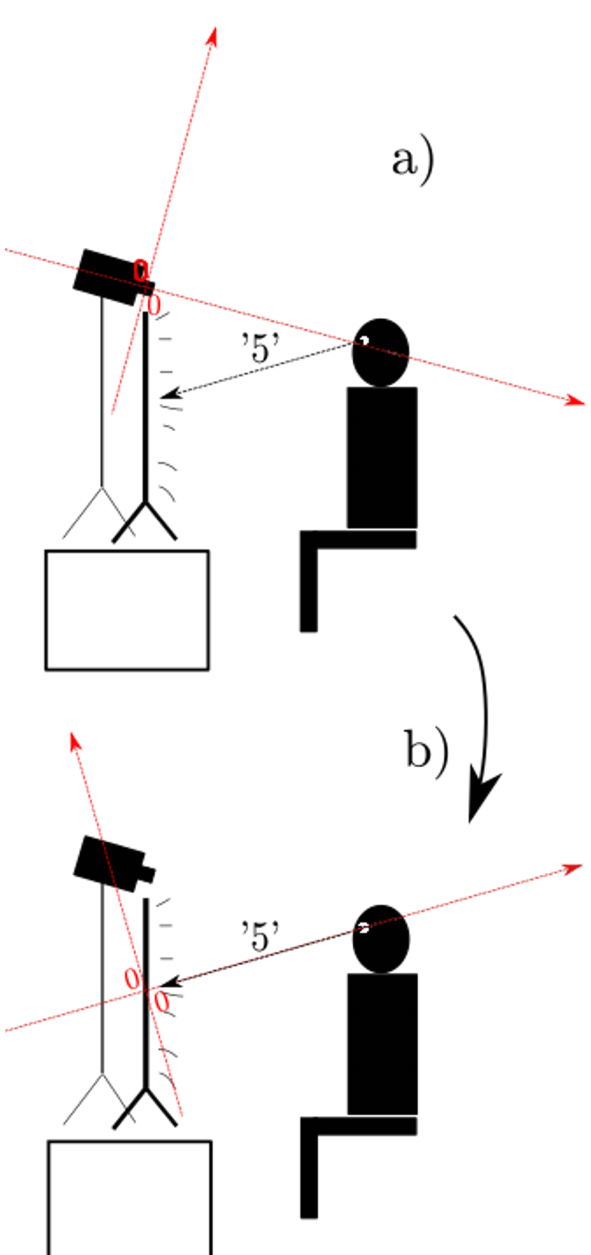
Figure 2. a) Experiment set-up in two dimensions for ease of representation; what is depicted here as a rotation around only one axis, was in reality a rotation around two axes. The coordinate system in red is the original coordinate system generated by OpenFace during the automatic annotation. The vector originating from the participant is the ‘5’ vector, i.e. the one that aimed at the center of the screen. b) After rotating the coordinate system, its origin is now in the center of the screen and oriented such that the x-axis coincides with the ‘5’